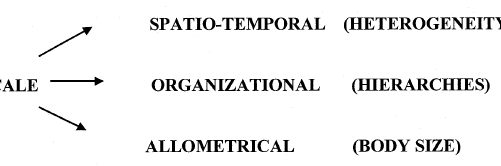
Fig. 1. Main scaling dimensions in ecology and related terms.